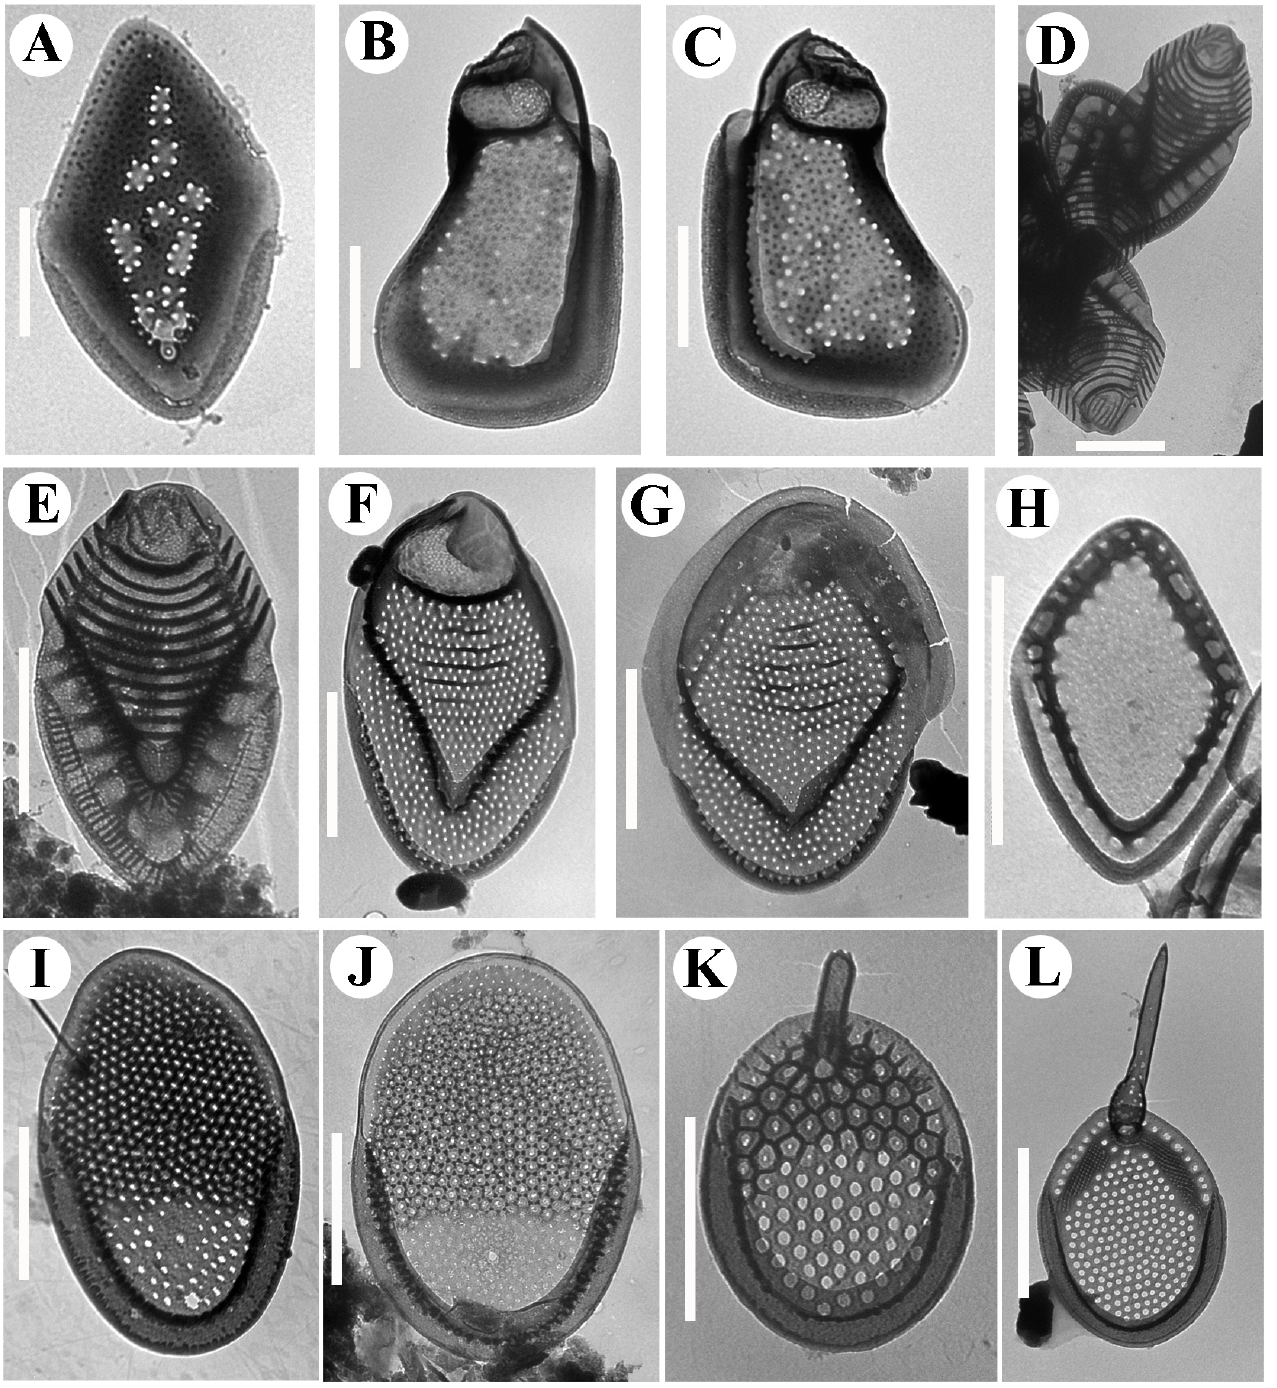
Figure 4. ( A – L ) Mallomonas and Synura taxa from Indonesian Papua, TEM. ( A – C ) Mallomonas solea-ferrea var. irregularis , body ( A ) and apical ( B , C ) scales. ( D , E ) Mallomonas striata var. serrata . ( F , G ) Mallomonas cf. portae-ferreae . ( H ) Mallomonas papuensis , a body scales. ( I ) Mallomonas sp. 1. ( J ) Mallomonas sp. 2. ( K ) Synura cf. longitubularis . ( L ) Synura mammillosa . Scale bars: ( D – L ): 2 µ m, ( A – C ): 1 µ